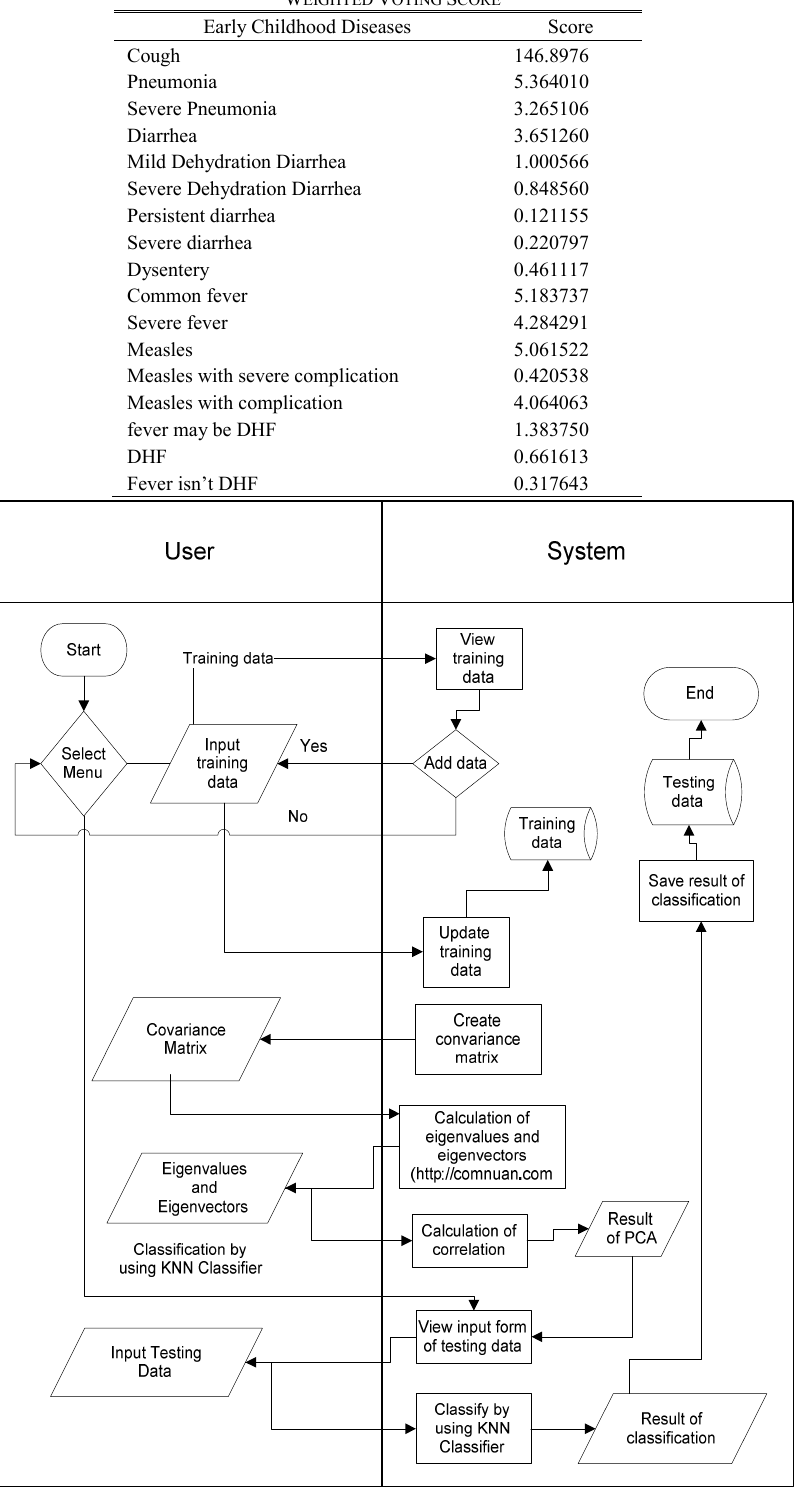
Fig. 2 System flow diagram for classification using PCA and